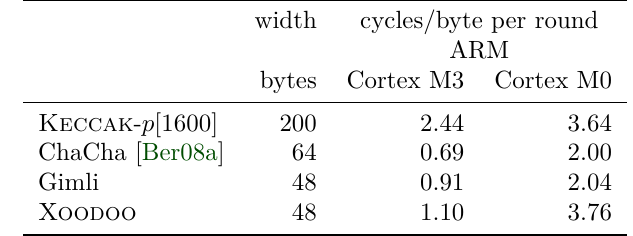
Table 4: Performance of a round of different permutations on Cortex-M3 and -M0 width cycles/byte per round ARM bytes Cortex M3 Cortex M0 Keccak - p [1600] 200 2 . 44 3 . 64 ChaCha [Ber08a] 64 0 . 69 2 . 00 Gimli 48 0 . 91 2 . 04 Xoodoo